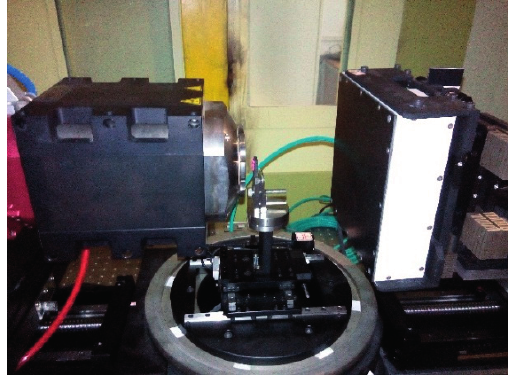
Figure 5. Photograph of the micro-CT system with a micro-focus X-ray source, rotation stage, and a flat panel detector.